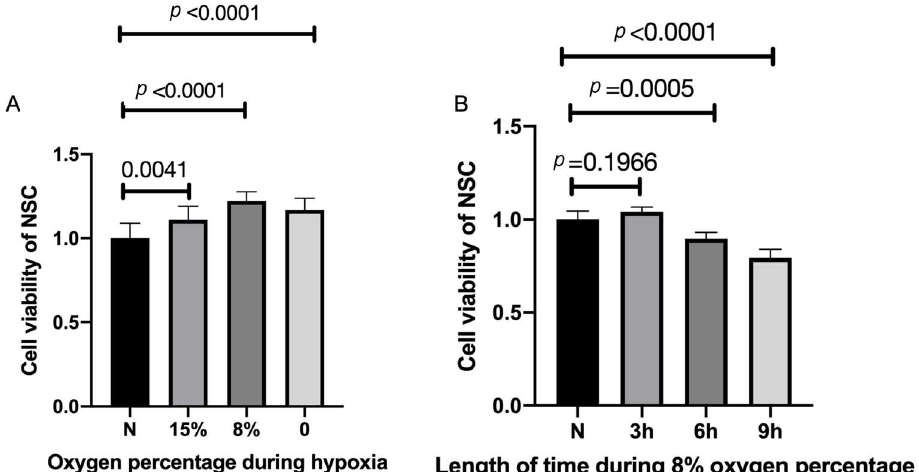
Figure 2. Increased cell viability after hypoxic preconditioning. ( A ) NSCs were exposed to 0%, 8%, 15%, and normal percentage of oxygen for three hours. n = 10, p < 0.05, each oxygen percentage group vs. normal group. ( B ) Three hours of hypoxic preconditioning of 15% and 0% oxygen exposure made no difference in cell viability, but the viability significantly increased after three hours of hypoxic preconditioning with the exposure of 8% oxygen. n = 10 cell culture wells per group, p < 0.05 each HP period of time group vs. normal group. Cell viabilities are all expressed as means ± SD.